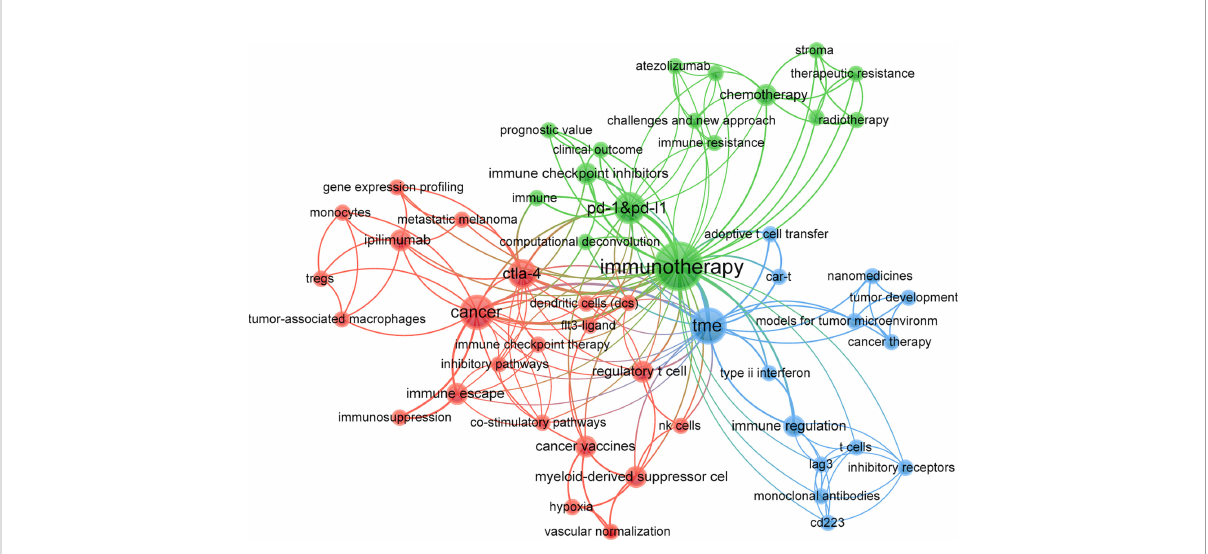
FIGURE 13 Keyword co-occurrence net and clusters in immunotherapy-TME studies (T ≥ 1; 52 items, 3 clusters, 183 links; maxlines = 1000). Note: Nodal point and word sizes denote co-occurrence frequencies, link the co-occurrence associations, and nodal color indicates